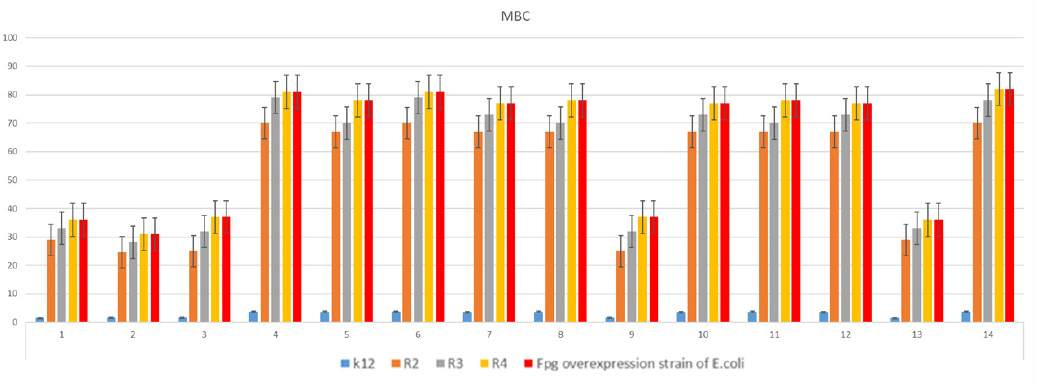
Figure 5. Minimum bactericidal concentration (MBC) of the coumarin derivatives. The x -axis fea- tures compounds 1 – 14 . The y -axis shows the MIC value in µg/mL. Investigated strains of E. coli K12 as control (blue), R2 strains (orange), R3 strain (grey), and R4 strain (yellow), Fpg overexpression strain (red bars). The order in which the compounds were applied to the plate are shown in Sup- plementary Materials Figure S1.